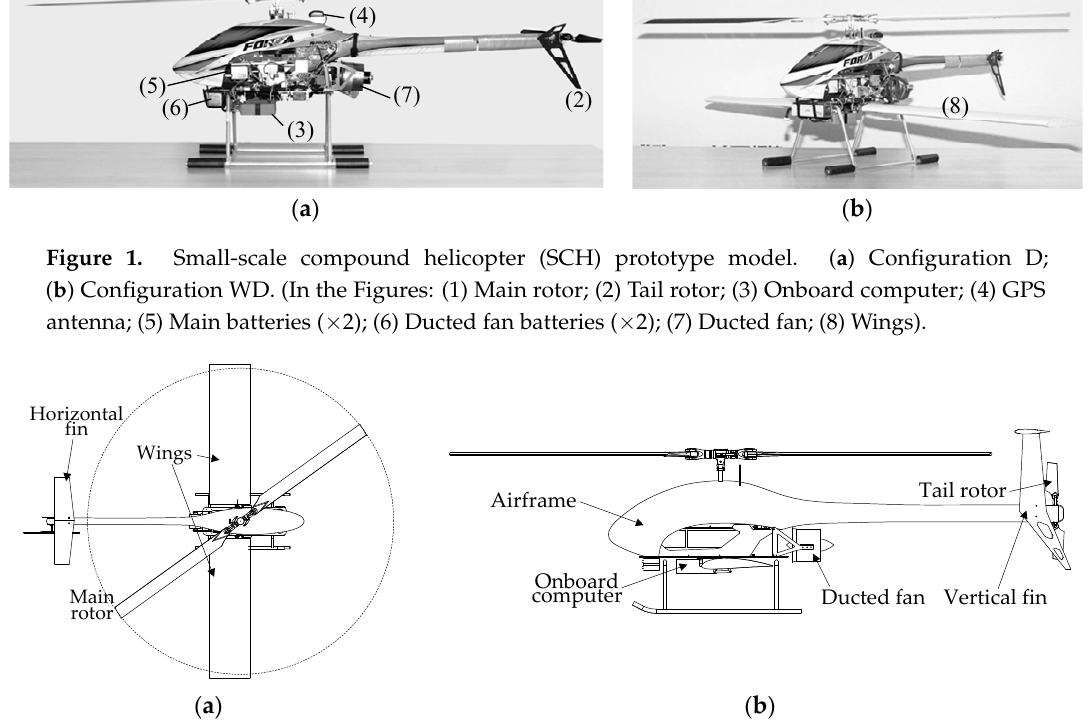
Table 1. Parameters from direct measurement.